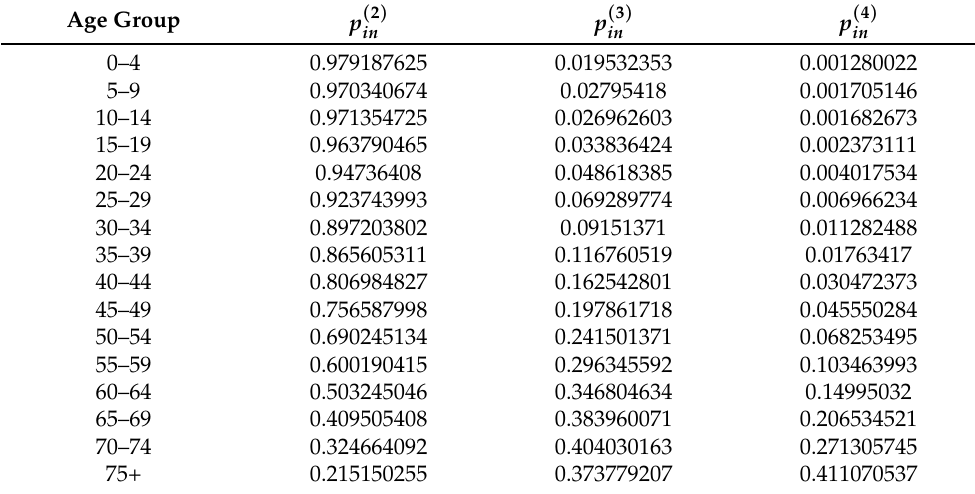
Table A2. Proportion of susceptible individuals from S in going to I j infectious class.